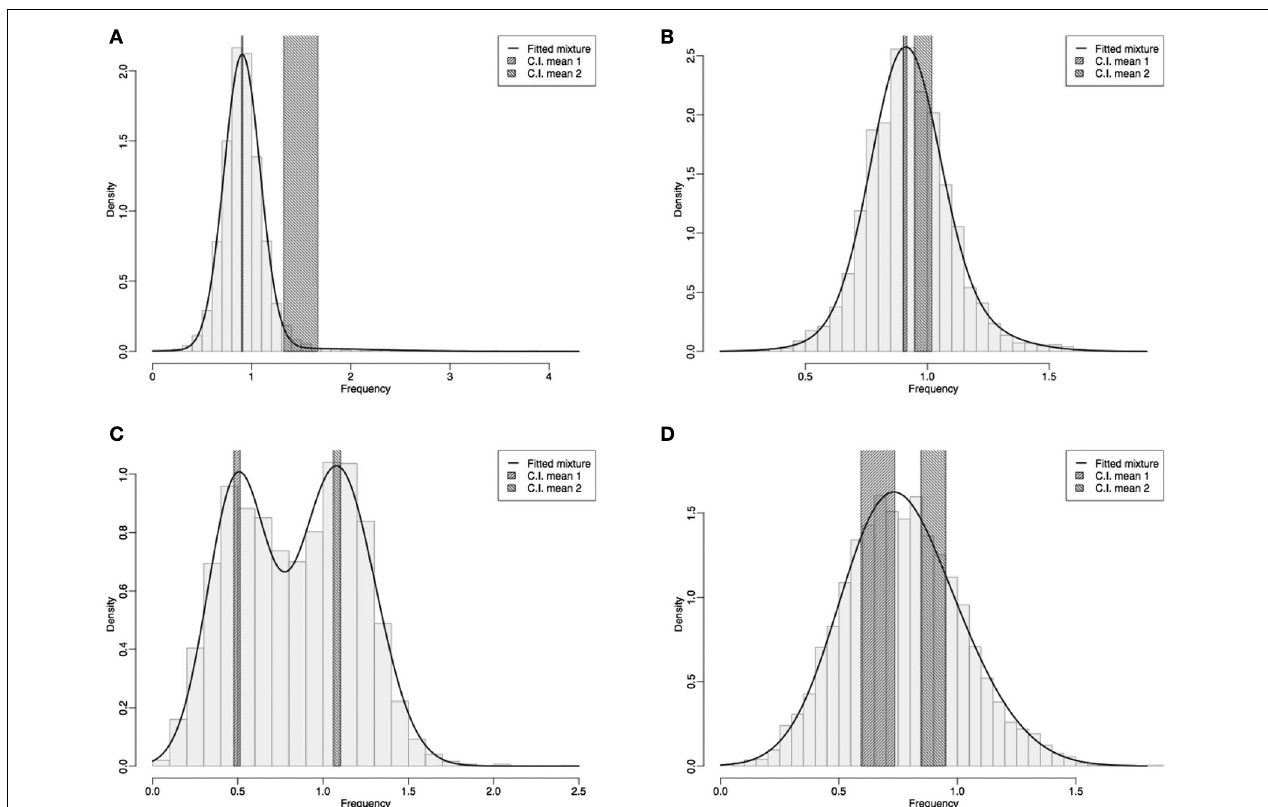
FIGURE 1 | Frequency distribution of CpG observed/expected ratio (CpGo/e) in four different species. (A) C. elegans and (B) D. melanogaster , and on (C) A. melifera and (D) M. incognita . CpGo/e ratio was measured as a proxy to estimate the CpG methylation in transcripts from EST data. X axis: